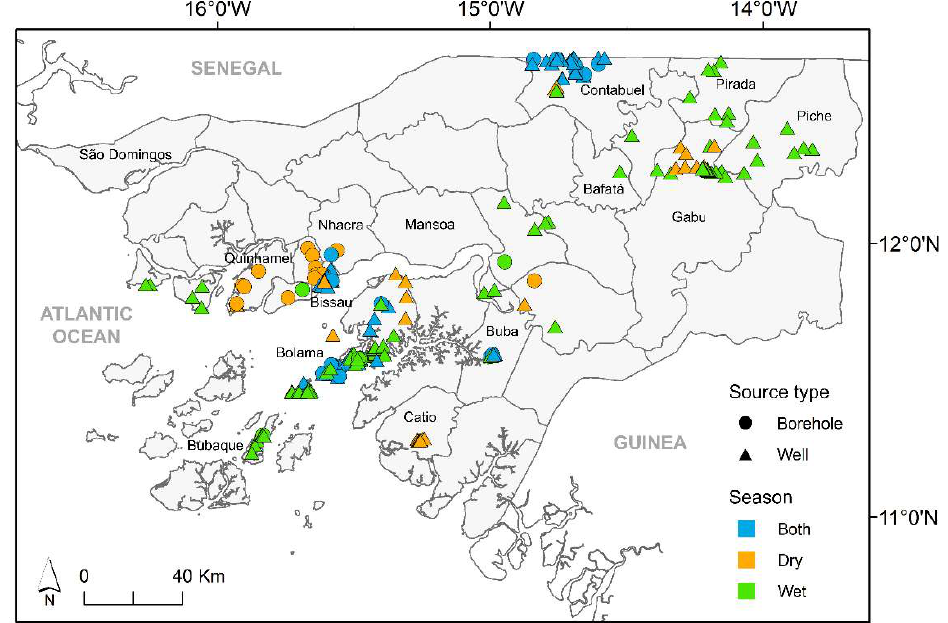
Figure 1. Location of surveyed water sources across Guinea-Bissau (source of second-level administrative divisions of Guinea-Bissau: Hjmans et al. [16]).